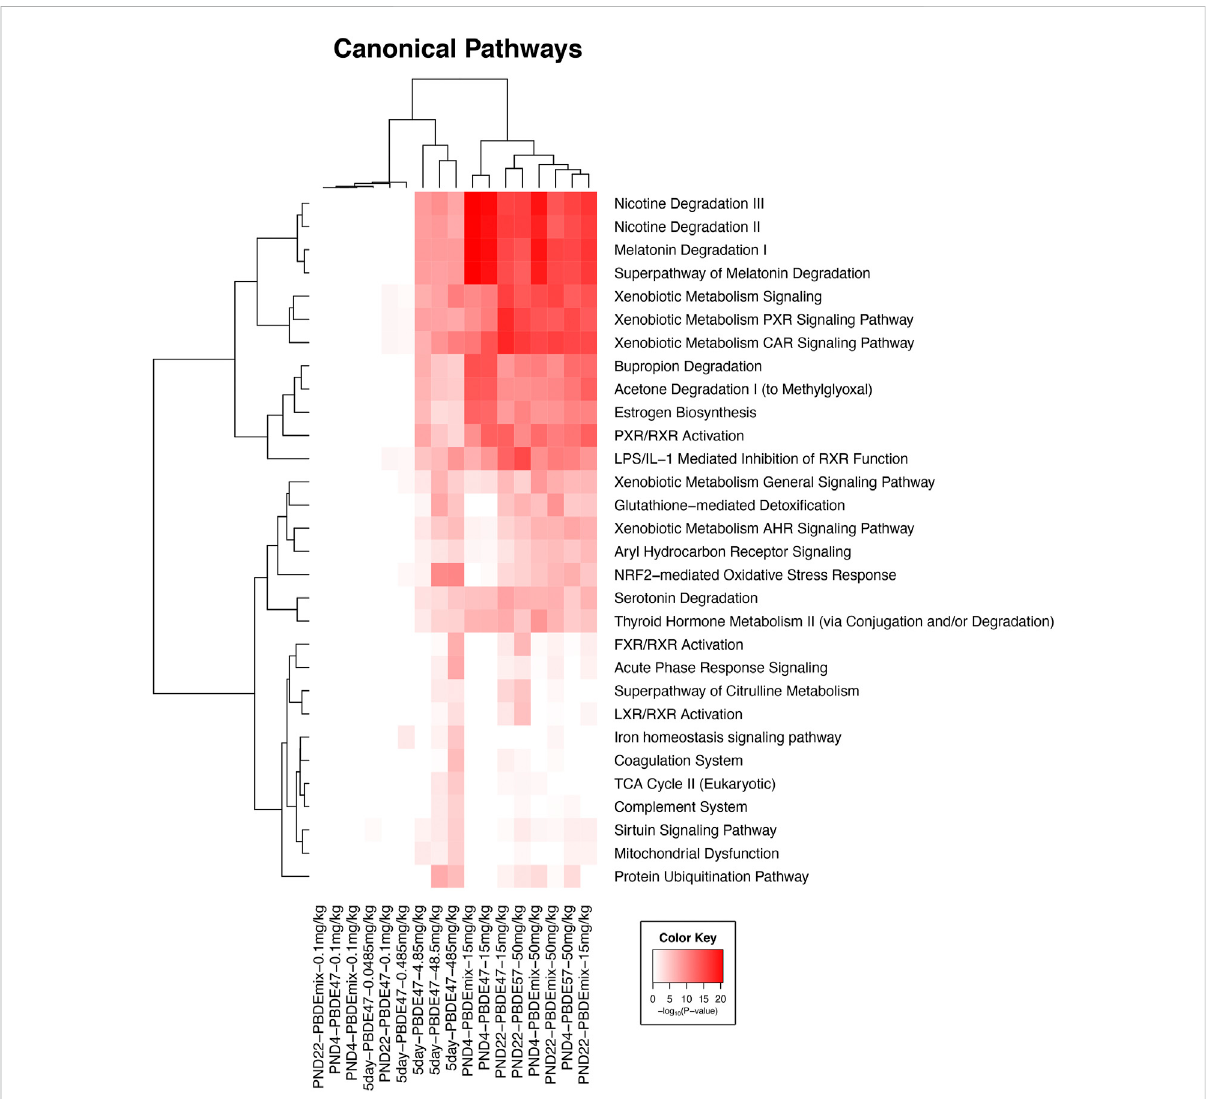
FIGURE 1 Clustered heat map of log 10 p -values associated with enriched Ingenuity Canonical Pathways associated with the changed transcripts from eachexperimentinall fi vegroupsinthisstudy.Includedpathwayshaveatleastonesigni fi cantpathwayaftermultipletestcorrection(FDR < 0.01).The color key scale indicates the minus log 10 p -value of pathway signi fi